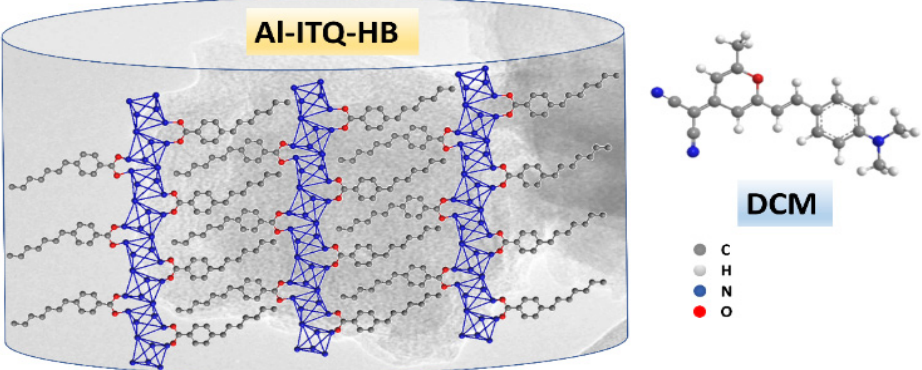
Scheme 1. Schematic representation (not in scale) illustrating the Al-ITQ-HB framework together with the molecular structure of DCM.